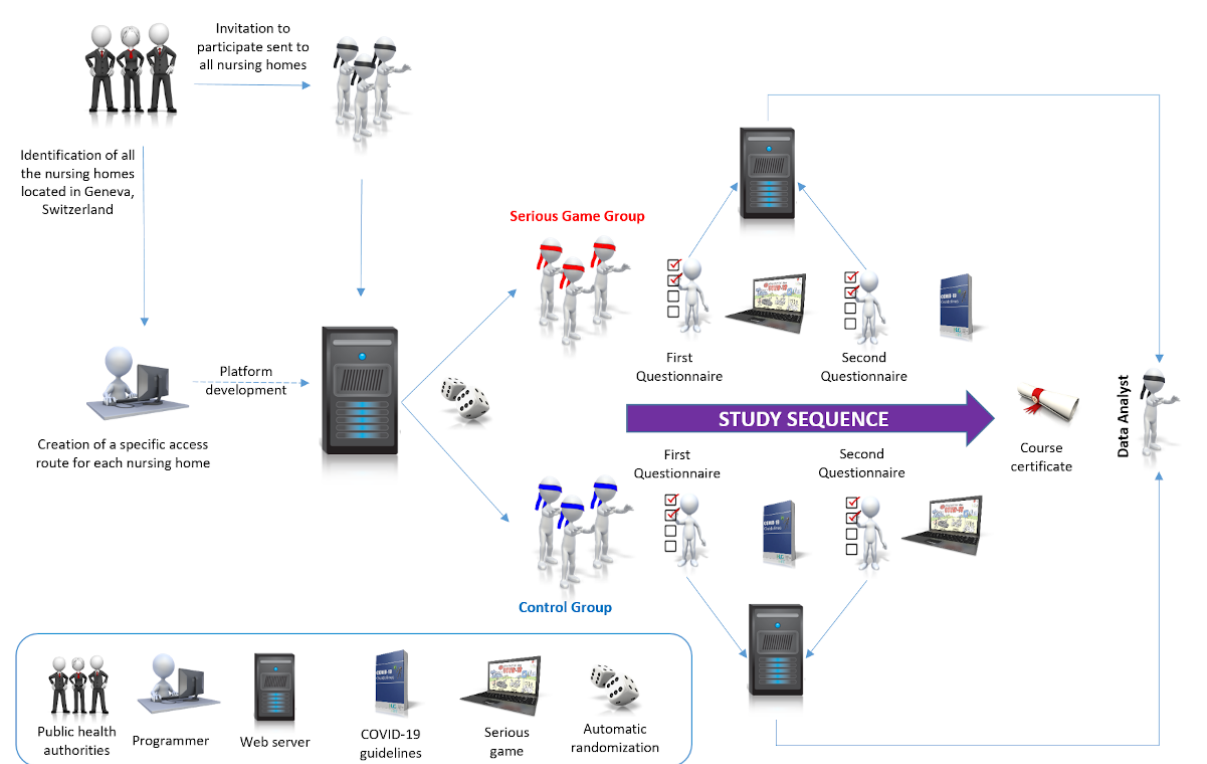
Figure 1. Study design and